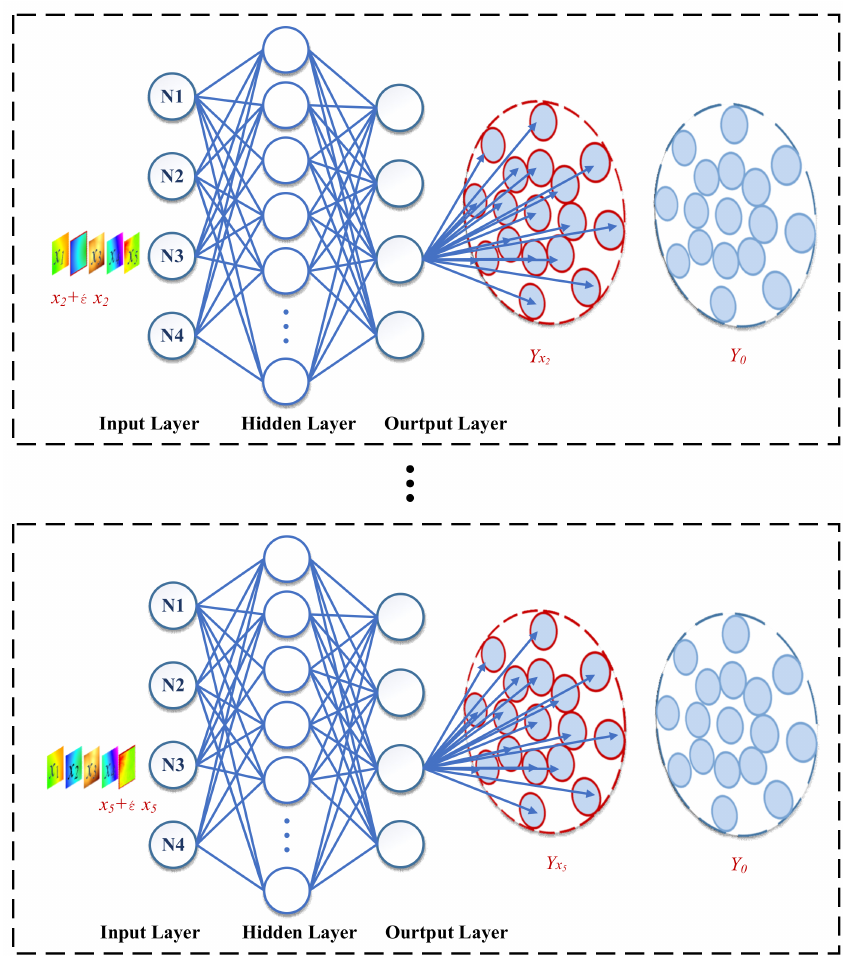
Figure 2. The modeling process of GWDF-ANN. N1, N2, N3, and N4 are the multiple input neurons composing the input layer. The first rectangular box shows the model after the first driving factor has been added with a bias to x 1 ( x 1 + ∆ x 1 ). The Yx 1 represents the predicted result after adding a bias. The second rectangular box shows the model after the first driving factor has been added with a bias to x 2 ( x 2 + ∆ x 2 ). The Yx 2 represents the predicted result after adding a bias. We do not show all the driving factors. The last rectangular box shows the model after the first driving factor has been added with a bias to x 5 ( x 5 + ∆ x 5 ). The Yx 5 represents the predicted result after adding a